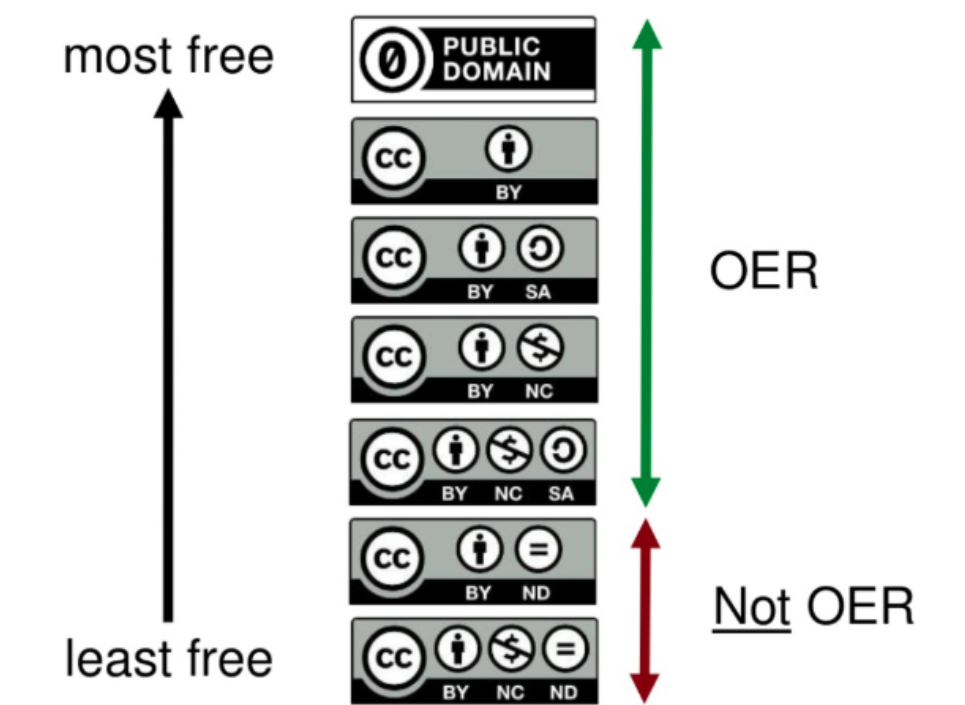
Figure 1 . Openness scale. From “Open Education: The Moral, Business and Policy Case for OER,” by C. Green, 2014 ( https://www.slideshare.net/cgreen/updated-keynote-slides-october-2014 ). CC